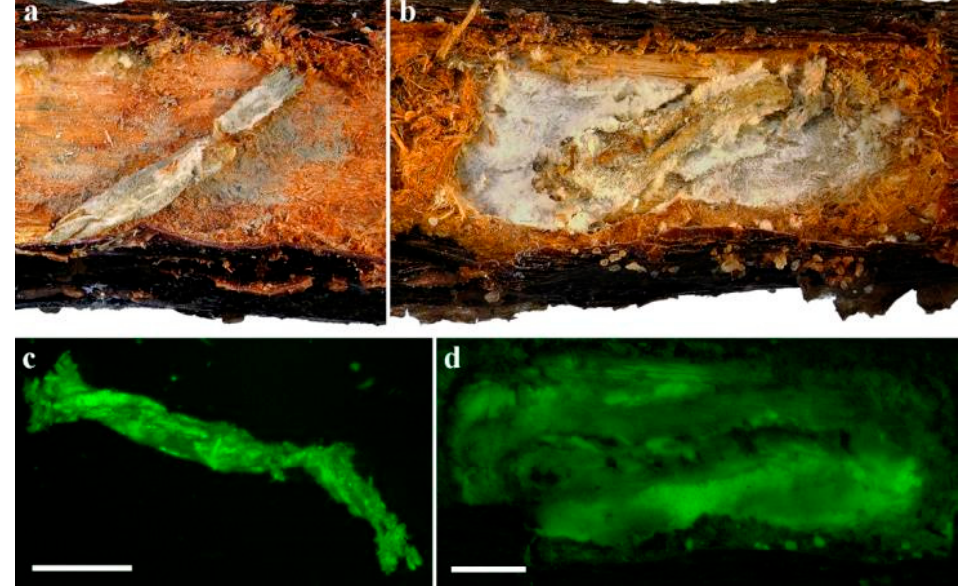
Figure 5. Gumming at the rootstock base 15 days after larval release: a) detail of the trunk base without adhering soil; b) detail of the trunk base and gum secretion at the level of the ground.